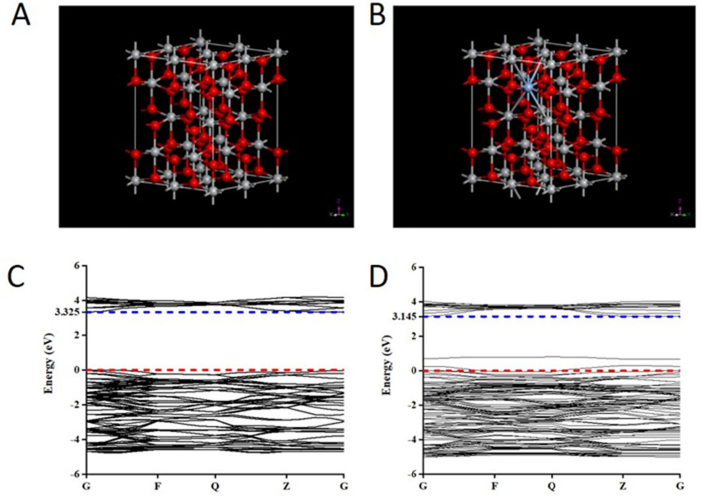
Figure 6. The crystalline structures of TiO 2 and Ag-doped TiO 2 ( A , B ) and the band structure of TiO 2 and Ag-doped TiO 2 ( C , D ) obtained through density functional theory analysis. The abscissa axis is in the indicated Brillouin zone for tetragonal structure of TiO 2 . The dashed red lines (energy zero) represent the valence-band maximum. The blue lines represent the minimum band gap at the G point.